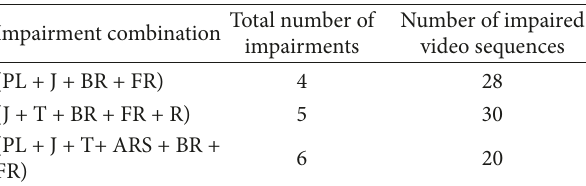
Table 8: Sequence detail for creating final video